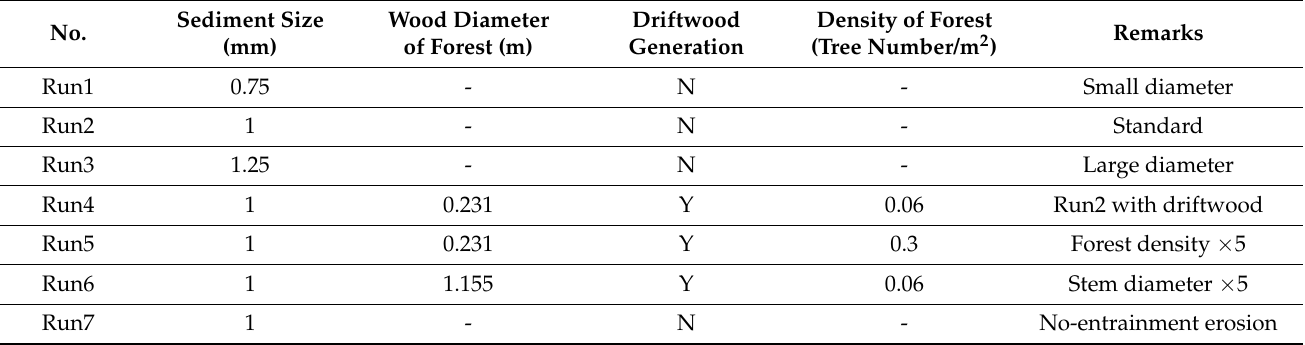
Table 2. Parameters of various factors for the simulation cases.